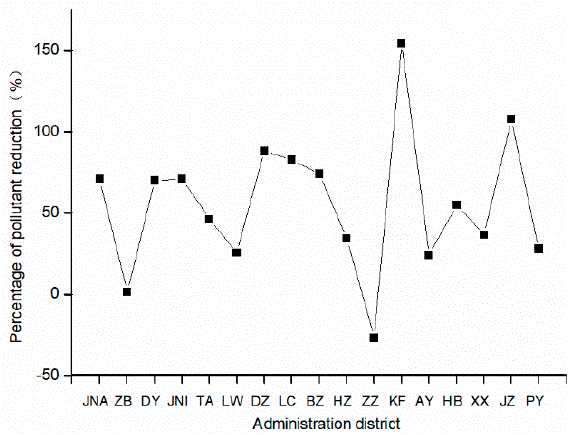
Figure 8. Declining rate of industrial and domestic pollutants in the lower reaches of the Yellow River from 2015 to 2016.